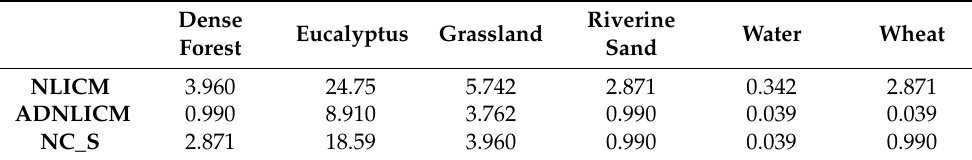
Table 11. SSE values for the proposed algorithms for site 1 (Haridwar).